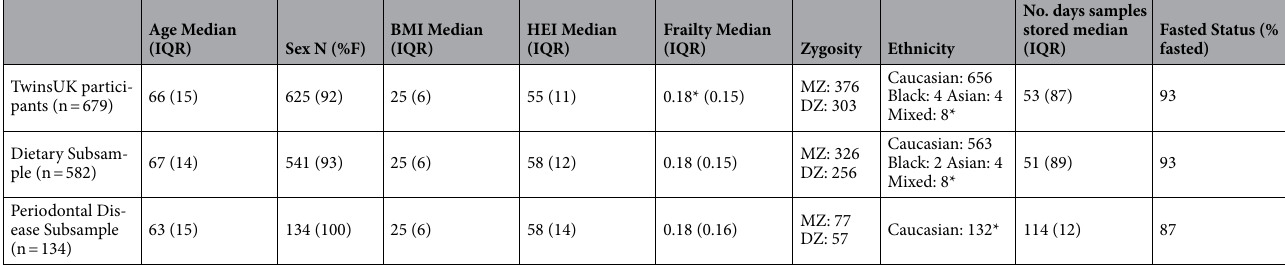
Table 1. Participant Characteristics. *Data unavailable for some